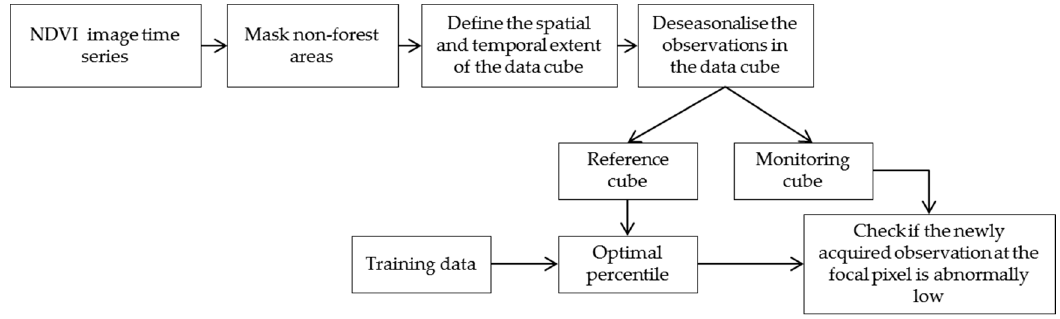
Figure 1. The workflow for detecting deforestation at sub-annual as extreme event in space-time data cube.